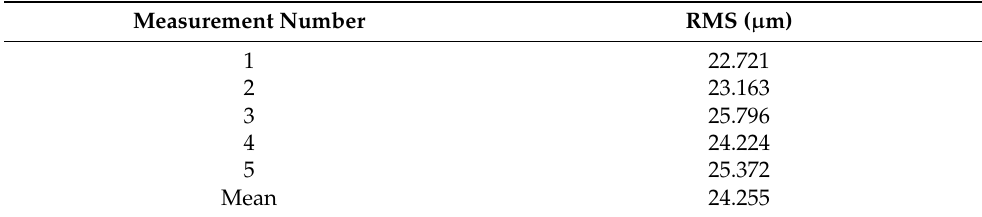
Figure 12. ( a ) The object measured by the system, ( b ) the measurement error of the system, ( c ) the object measured by LuphoScan, and ( d ) the measurement error of LuphoScan. Table 6. The results of repeated measurement of the conical